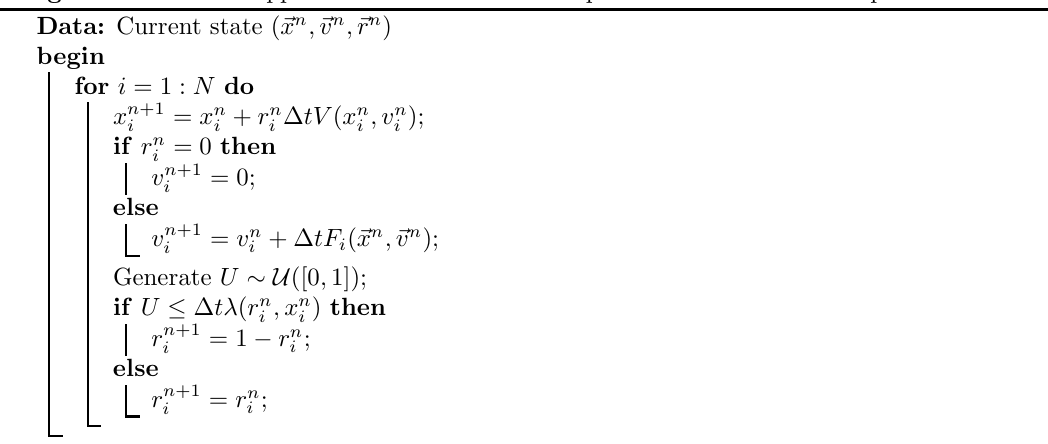
Figure 3: Overview of the deterministic and stochastic model hierarchy equations implies that the status of each pedestrian r n according to a Bernoulli distribution with probabilities p i = ∆ tλ ( r n function. Summarizing, we obtain algorithm 1. Algorithm 1: Euler approximation of the microscopic model for one